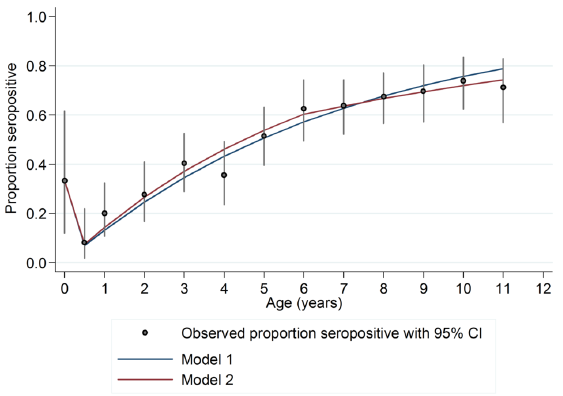
Figure 1. Observed prevalence by age (with 95% CIs) and model-predicted values. Blue line: Model 1 (constant force of infection); Red line: Model 2 (different forces of infection above and below 6